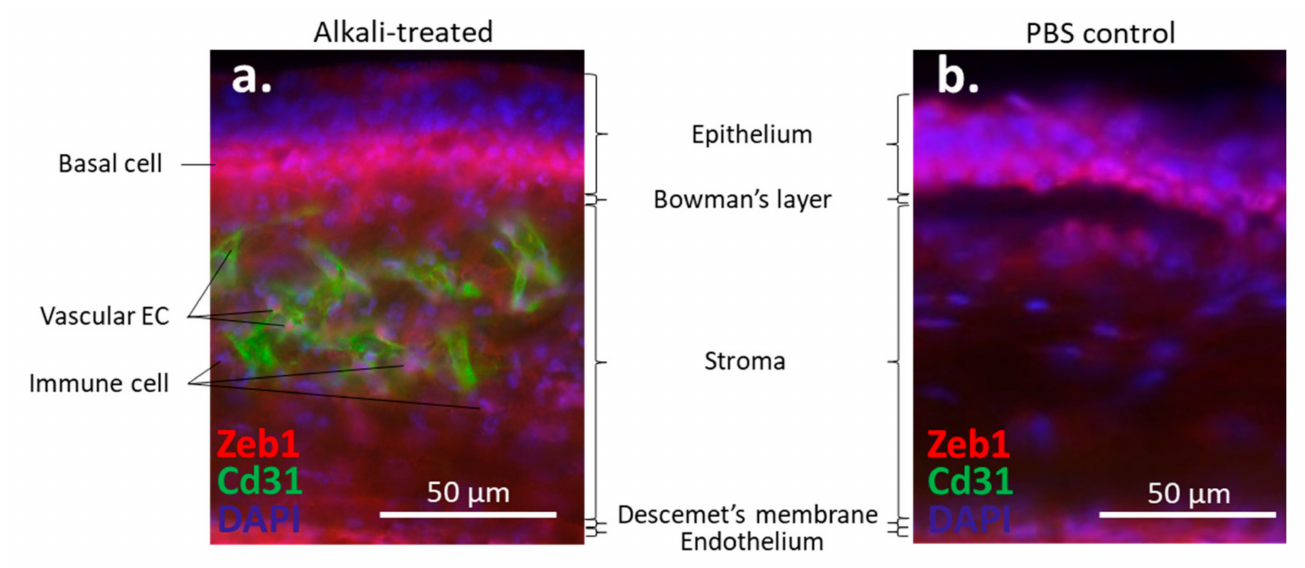
Figure 2. Alkali-induced mouse corneal neovascularization (NV). ( a ) In the alkali-treated cornea, Zeb1 is highly expressed in epithelial basal cells (BC), Cd31-expressing vascular endothelial cells (EC), and infiltrated immune cells (IC). ( b ) In the PBS control cornea, no Cd31-positive EC and IC are